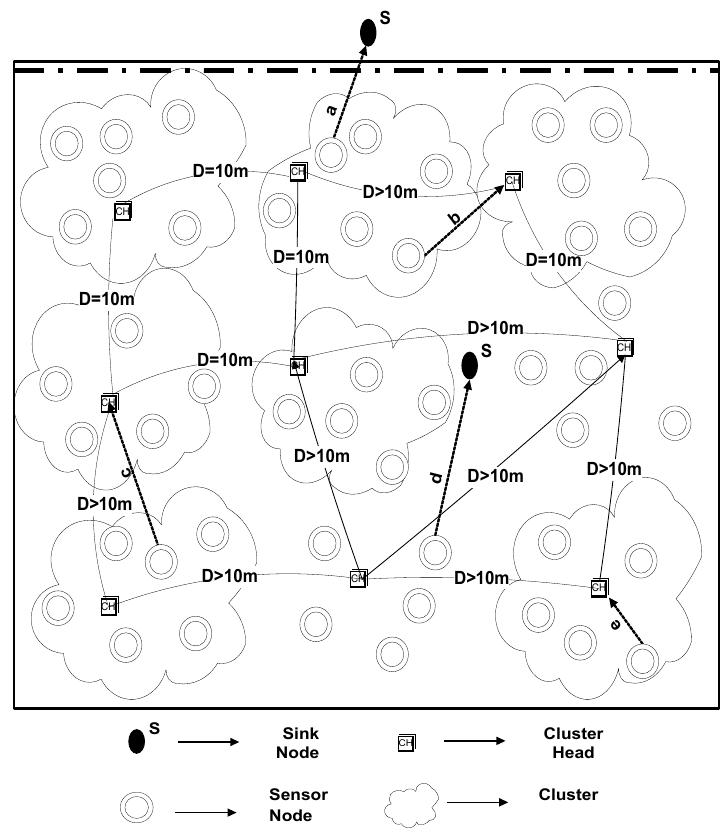
Figure 13. U-(ACH) 2 with One Sink at Water Surface and One